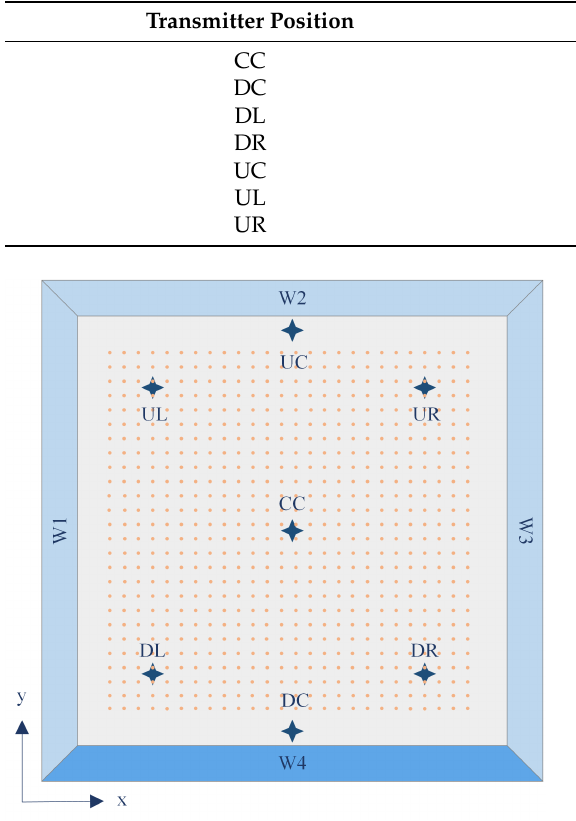
Table 3. The coordinates of transmitters.